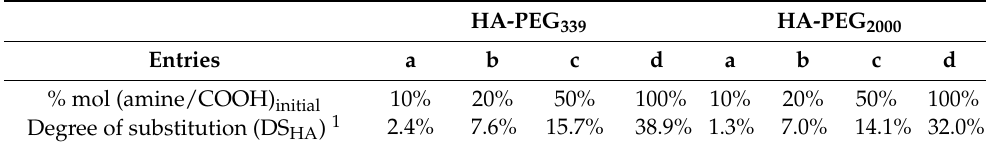
Table 2. Degrees of substitution of HA functionalized with oligo-ethyleneglycol-amines. HA-PEG 339 HA-PEG 2000 Entries a b c d a b c d % mol (amine/COOH) initial 10%